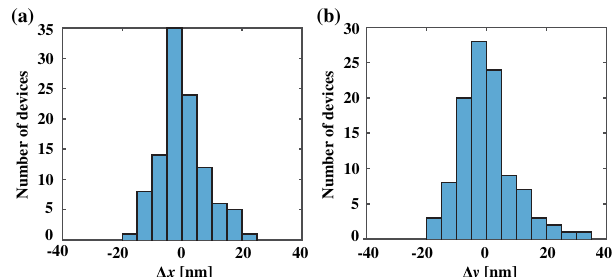
FIG. 9. QD-PC cavity alignment fluctuations within several square arrays. (a),(b) Histograms of x and y alignment deviations from Δ mean values calculated from alignment data measured in several PC cavities in each array (data from 14 different arrays, several devices per array).